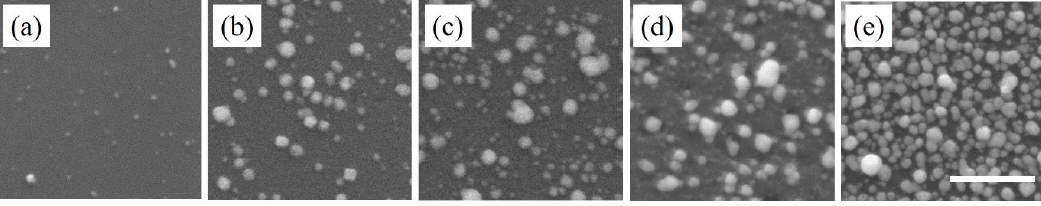
Figure 3. SEM images of Cu-based nanostructures deposited on Si substrate after ( a ) first, ( b ) second, ( c ) third, ( d ) fourth and ( e ) fifth deposition cycle. The scale bar is 500 nm.